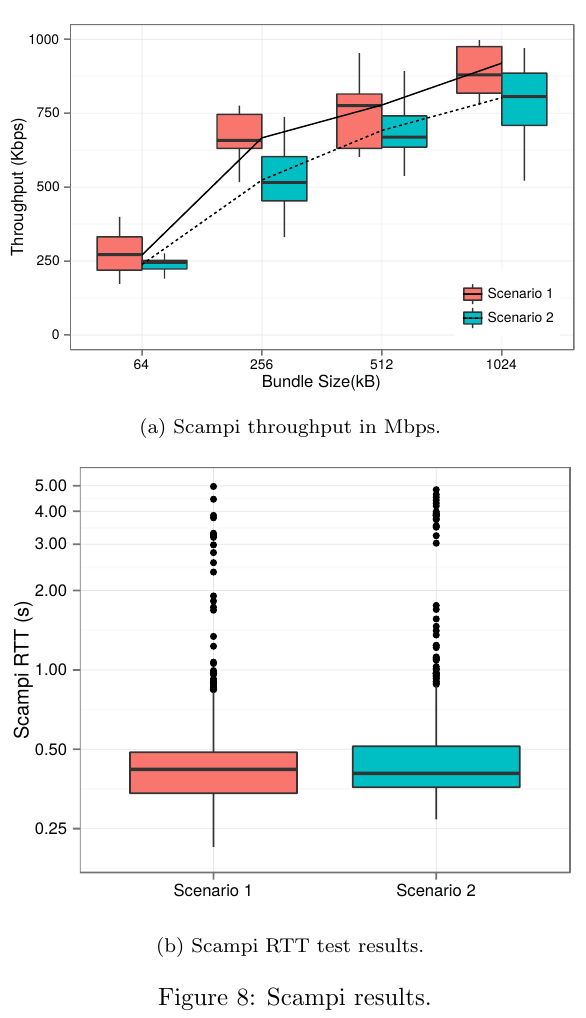
(b) Scampi RTT test results. Figure 8: Scampi